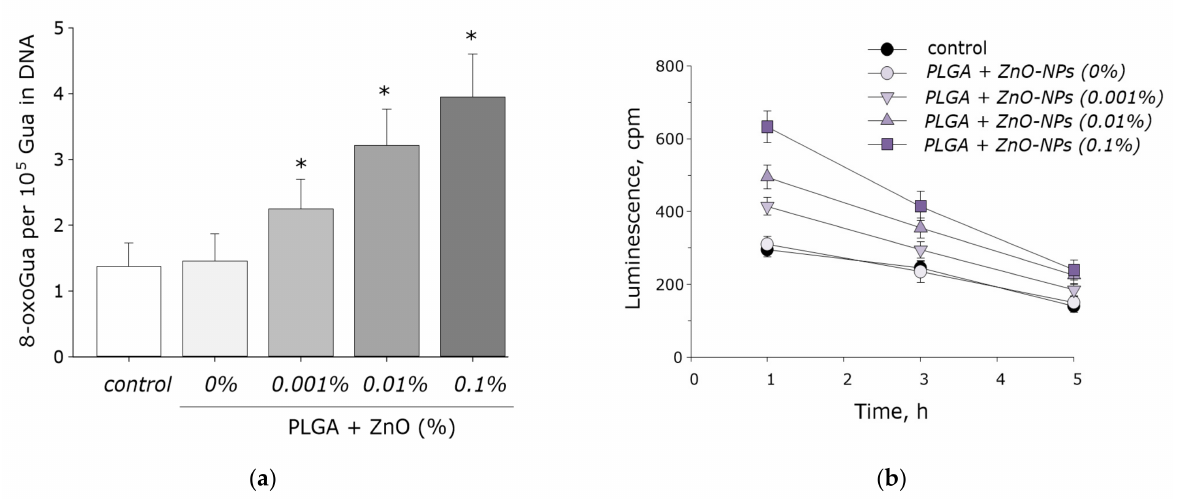
Figure 8. The effect PGLA/ZnO-NPs composite on the biomacromolecules damage formation: ( a ) Gener- ation of 8-oxo-G in DNA in vitro (2 h, 45 ◦ C); ( b ) Formation and dynamics of decomposition of long-lived reactive protein species (2 h, 40 ◦ C); * indicate a significant difference at 5% level in comparison with the control ( p < 0.05). Data are presented as mean values and standard errors of